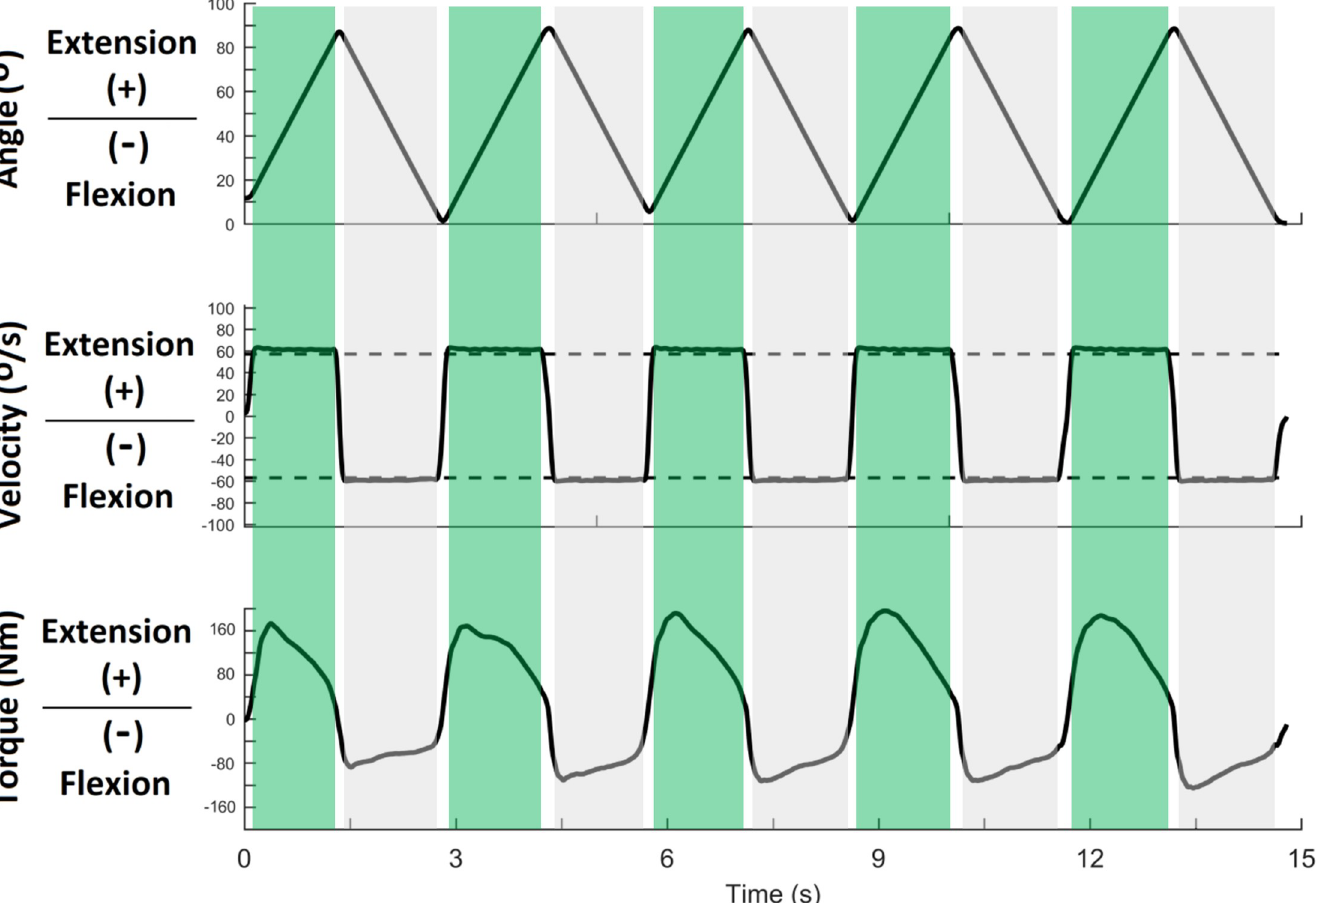
Fig 2. Curves resulting from the processing of kinematic and ground reaction force data and reconstruction of a kick by an elite athlete from the kinematic analysis. The subplots of the first column are the angular position curves, while the subplots of the second column show the respective angular velocities for hip and knee joints (1st to 3rd line of subplots). The 4th line of subplots contains the curves for the resultant ground reaction force and resultant linear velocities of pelvis, knee and foot. The light gray area represents the preparation phase and the dark gray area the impact phase; t1 : onset of the preparation phase; Peak GRF: Peak ground reaction force; t2: end of the preparation phase and onset of the kicking phase; PFK: instant of peak knee flexion; PFV: instant of peak foot linear velocity; t3: end of the kicking phase and start of the impact.